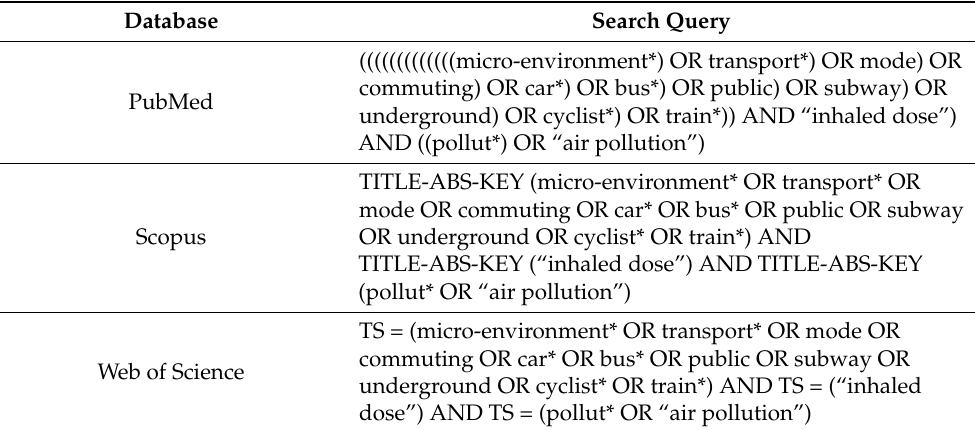
Table 1. Queries used for the search in the three different databases.